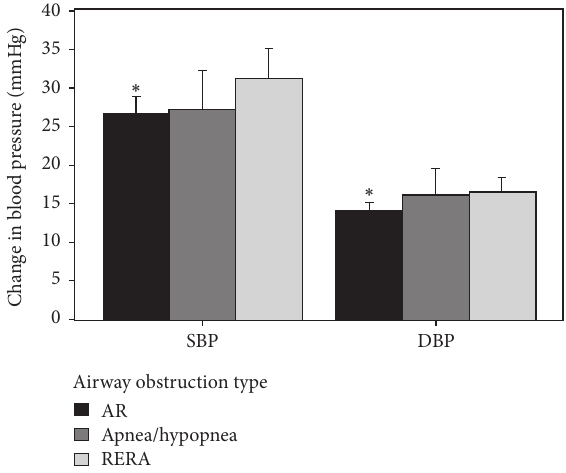
Figure 2: Blood pressure responses to RERA, apnea/hypopnea, and AR events among patients ( 𝑛 = 27 ) with RDI < 5. Data are the modeled response (mean ± 95% confidence interval) adjusted for repeated measures. AR, airflow reduction; RERA, respiratory event related arousal; mmHg, millimeters of mercury; ∗ 𝑝 < 0.05